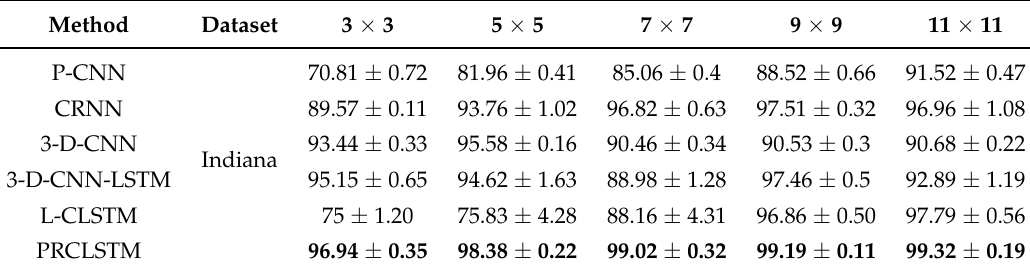
Figure 12. The test Errors (TEs) of the various methods with different window sizes of the input cube for ( a ) Indiana, ( b ) PaviaU, and ( c ) Salinas. Table 9. The overall accuracy (OA%) of different window sizes of the input cube for the three